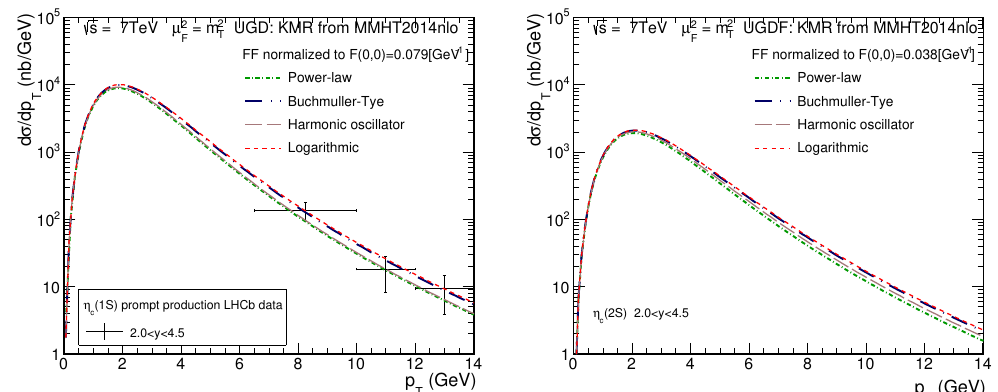
Figure 9 . Transverse momentum distributions calculated with several di(cid:11)erent form factors ob- tained from di(cid:11)erent potential models of quarkonium wave function and one common normalization of j F (0 ; 0) j as explained in the text.